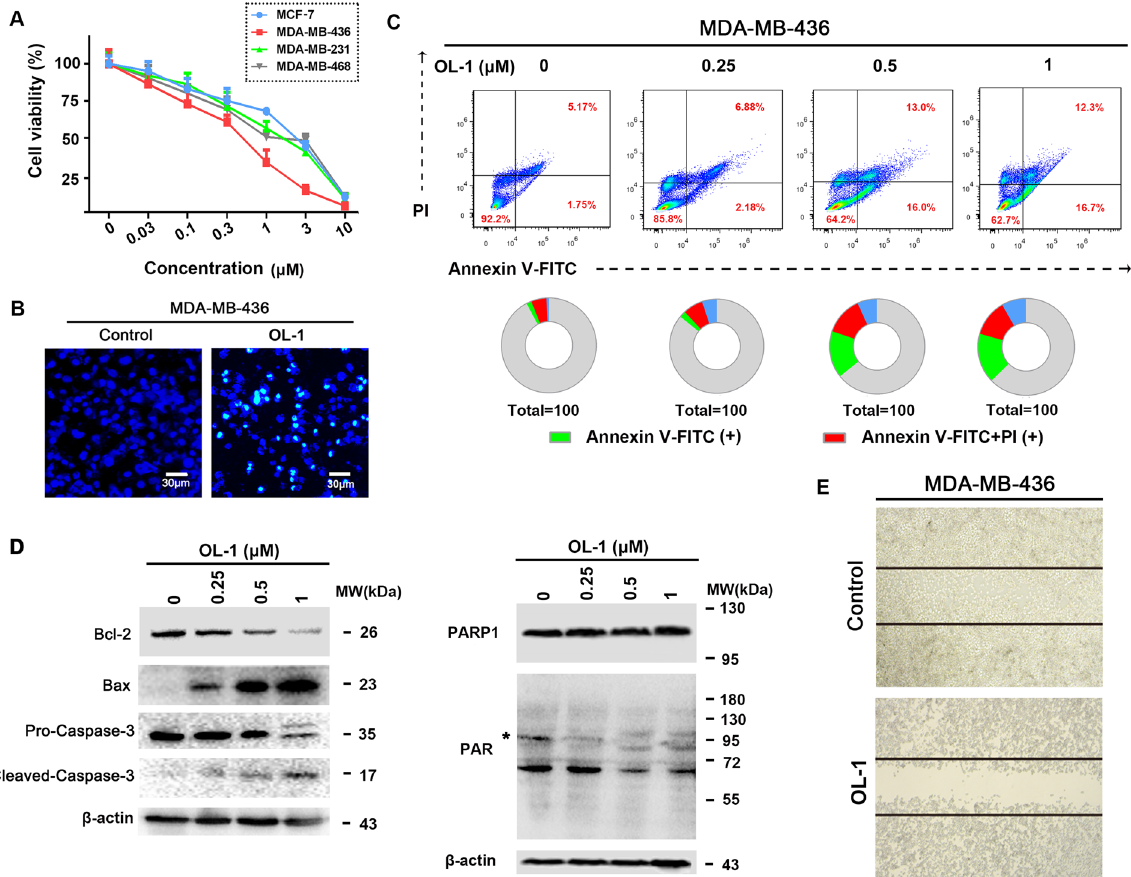
Figure 11. OL-1 induces cell death in breast cancer cells. ( A ) MCF-7, MDA-MB-231, MDA-MB-436, MDA-MB-468 cells were treated with different concentrations of OL-1, and then the cell viabilities were detected by MTT assay. ( B ) Hoechst 33258 fluorescence staining was used to detect DNA breakage. Scale bar = 200 μ m. ( C ) MDA-MB-436 cells were treated with 0.25 μ M, 0.5 μ M and 1 μ M OL-1 for 24 h, respectively. After Annexin V-FITC/PI double staining, the apoptosis ratios were analyzed by flow cytometry. ( D ) Western blot analysis of Bax, Bcl-2, Caspase-3, PARP1 and PAR expression levels in OL-1 treated cells. Each lane was loaded with 30 μ g cell lysates, β -actin was used as a loading control. ( E ) MDA-MB-436 cells were scratch- wounded by sterile pipette, and then treated with OL-1 for 24 h. Migrated cells were observed by phase-contrast microscope. Scale bar = 100 μ